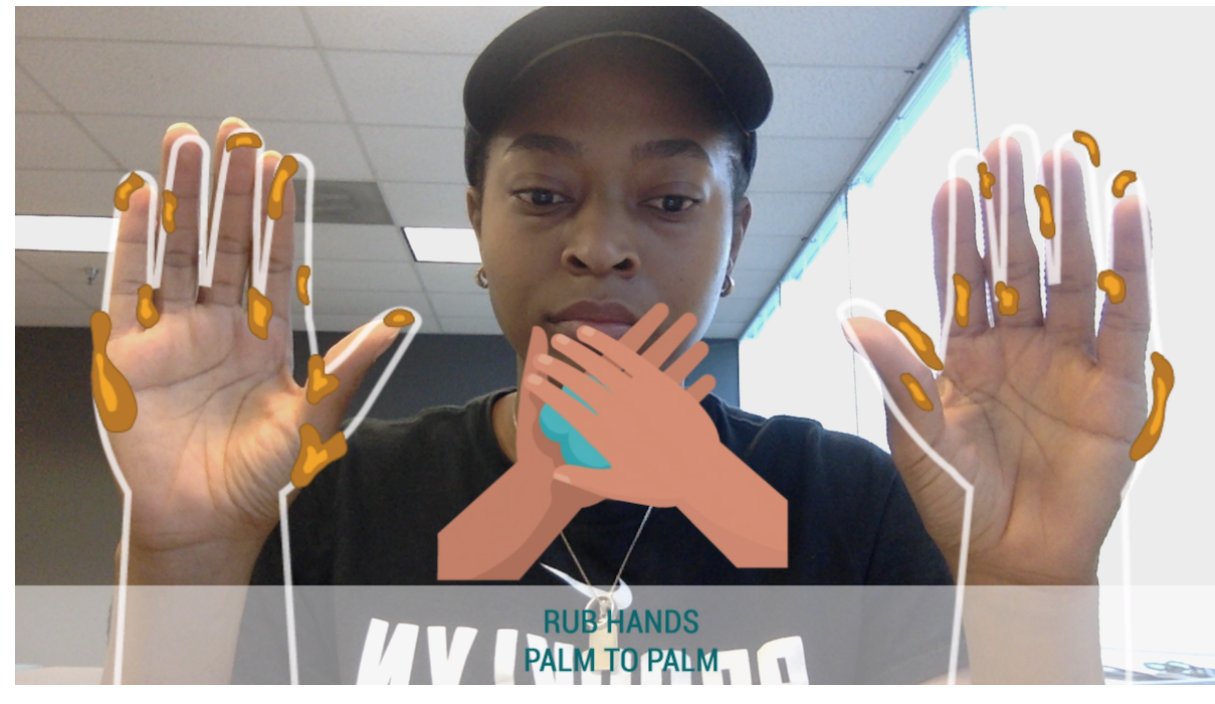
Figure 2. A screenshot from the web application.